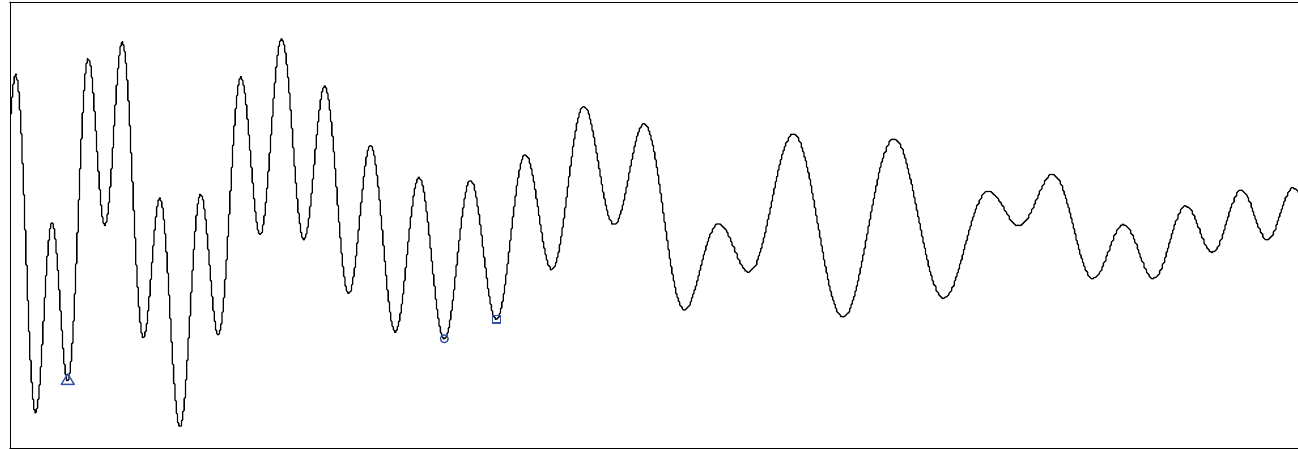
Fig. 3. An example of when both the ternary search and golden-section search find different local minima (the circled and squared points, respectively), and the genetic algorithm fails to find the global minimum (considering the function values, a local minimum found by the genetic algorithm and marked as the triangled point is pretty close to the global minimum but still it is not the global minimum; moreover, there is another local minimum which is even closer to the global